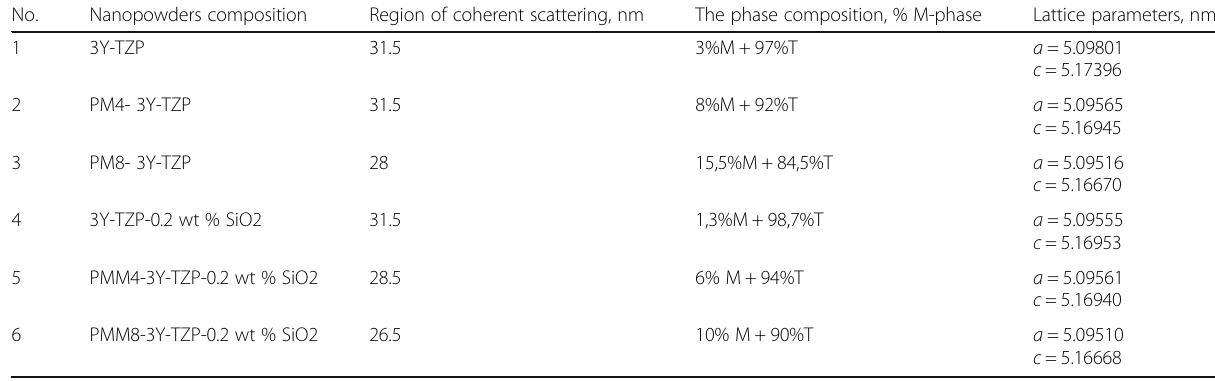
Table 1 The X-ray analysis results